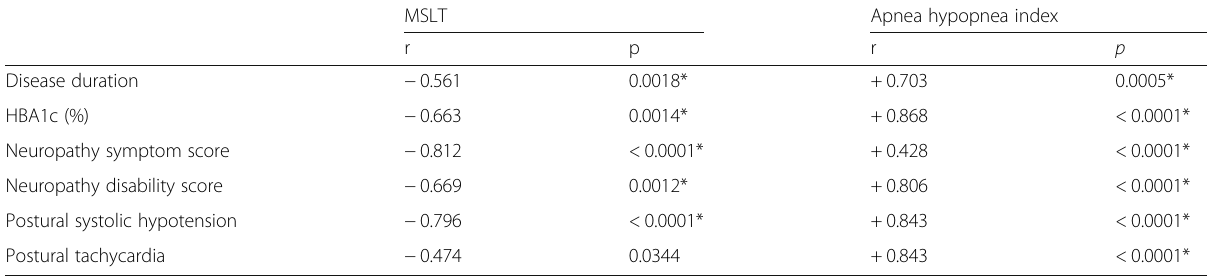
Table 3 Correlations of the multiple sleep latencies and apnea hypopnea indices with other variables in diabetic peripheral neuropathy patients